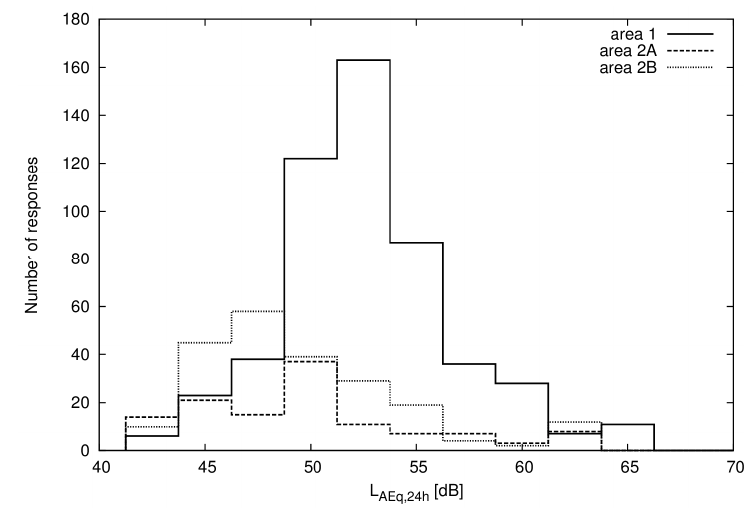
Figure 1. Histogram of number of responses in 2.5 dB intervals of equivalent noise level for area 1 (no vibration) and area 2 (noise and vibration).